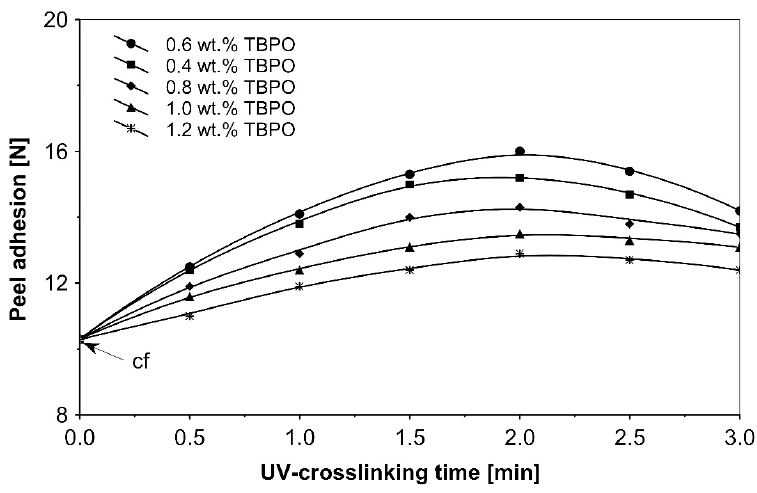
Figure 6. Peel adhesion versus UV-crosslinking time for the use of tris-benzophenyloxy phosphineoxide (TBPO).